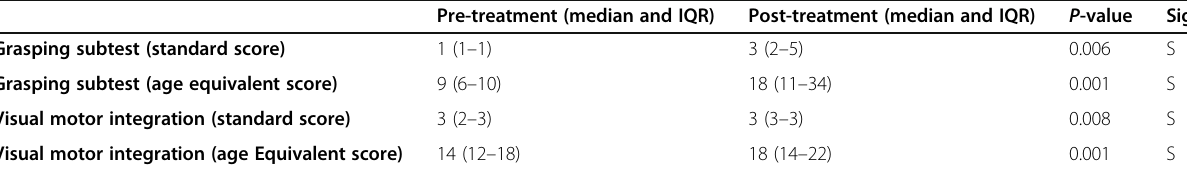
Table 2 Comparison of pre-treatment and post-treatment results of the control group Pre-treatment (median and IQR) Post-treatment (median and IQR) P -value